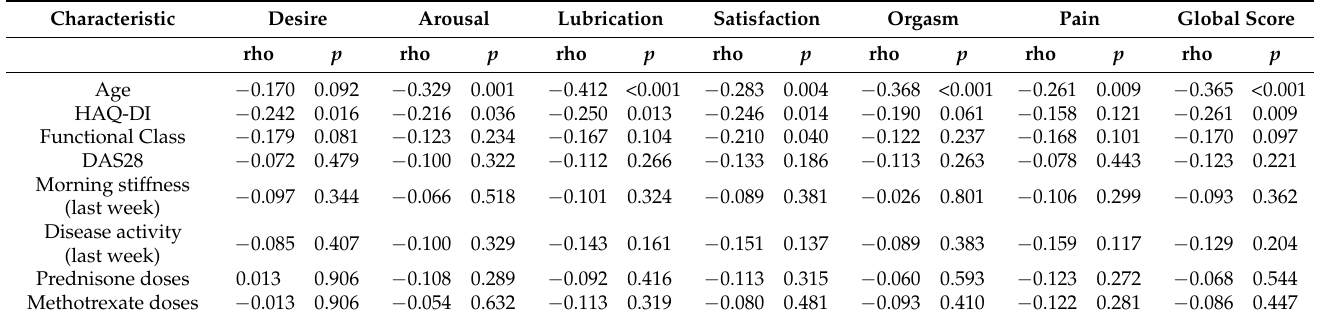
Table 4. Correlations between characteristics associated with sexual dysfunction in patients with rheumatoid